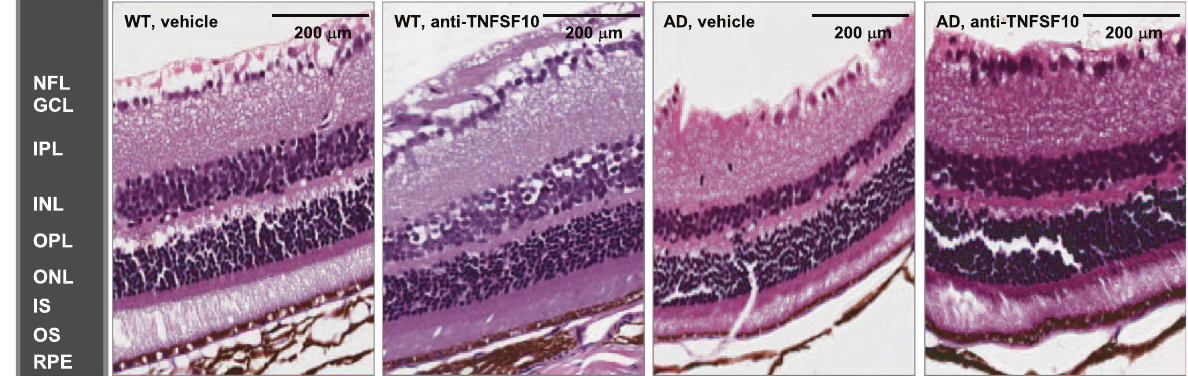
Fig. 4 TNFSF10-neutralizing antibody treatment preserved retinal structure in 15-month-old 3xTg-AD mice. Hematoxylin and eosin staining of retinal tissue of WT and 3xTg-AD mice were performed to analyze retina morphological changes following chronic treatment with vehicle or TNFSF10-neutralizing antibody. Original magni fi cation, x200. Scale bar = 200 µm. N = 5 animals; 5 independent retinal samples per group. NFL nerve fi ber layer, GCL ganglion cell layer, IPL inner plexiform layer, INL inner nuclear layer, OPL outer plexiform layer, ONL outer nuclear layer, IS inner segment; OS outer segment, RPE retinal pigment